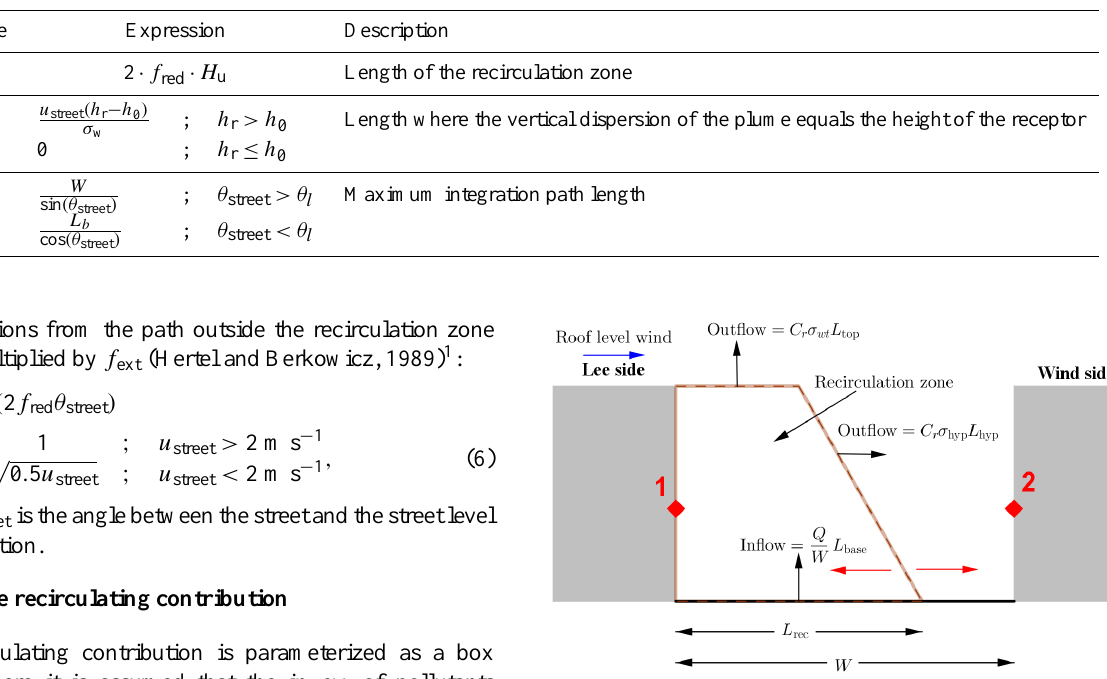
Table 4. Table of the critical lengths along the integration path. These lengths determine the upper and lower limits of the integrals in the homogeneous emission dispersion scheme and of the sums in the inhomogeneous emission dispersion scheme. Moreover, they determine if the dispersion should be calculated according to Eqs. (3) or (5) plus whether the concentration should be multiplied with f ext as defined in Eq. (6). f red is the shortening function as defined in Eq. (6), H u is the upwind building height, θ street is the wind direction compared to the street direction, θ l is the critical wind direction as illustrated in Fig. 5, W is the street width, L b is the length from the receptor to the end of the street as illustrated in Fig. 5, and h r is the height of the inlet of the receptor above street level.